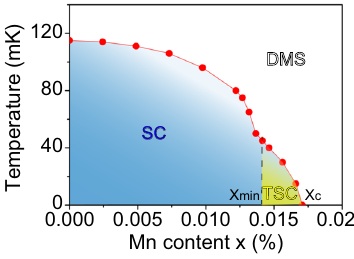
Fig. 4 The schematic phase diagram of the 0.1-hole-doped Ge 1- x Mn x Te monolayer. The yellow shaded region marks the TSC phase.